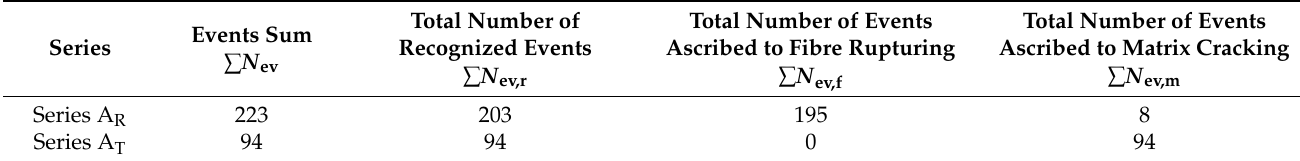
Table 4. Events recognized as accompanying rupturing of fibres and cracking of cement matrix for boards of series A R and A T .